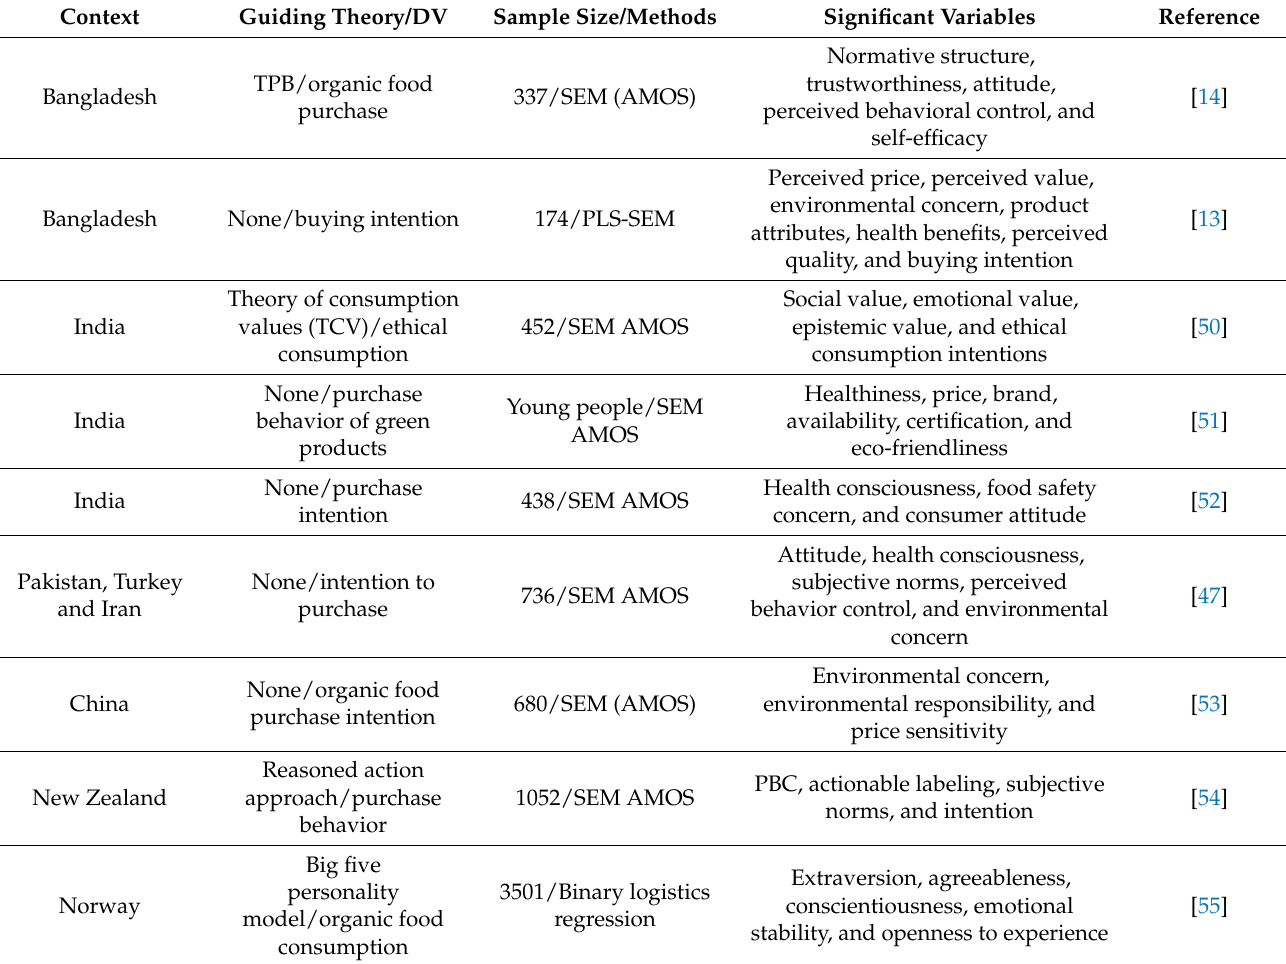
Table 1. Empirical Literature on Organic